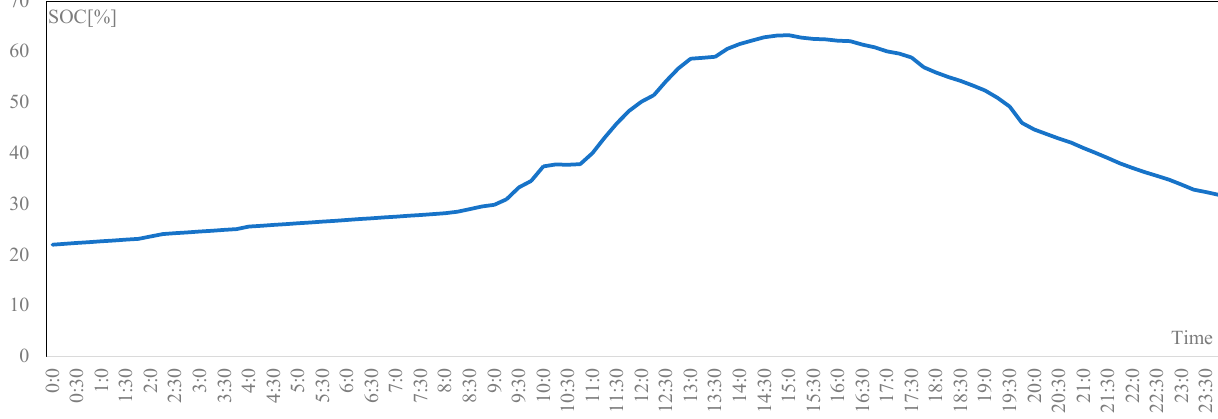
Table 3. Flexibility services requested to the REC.